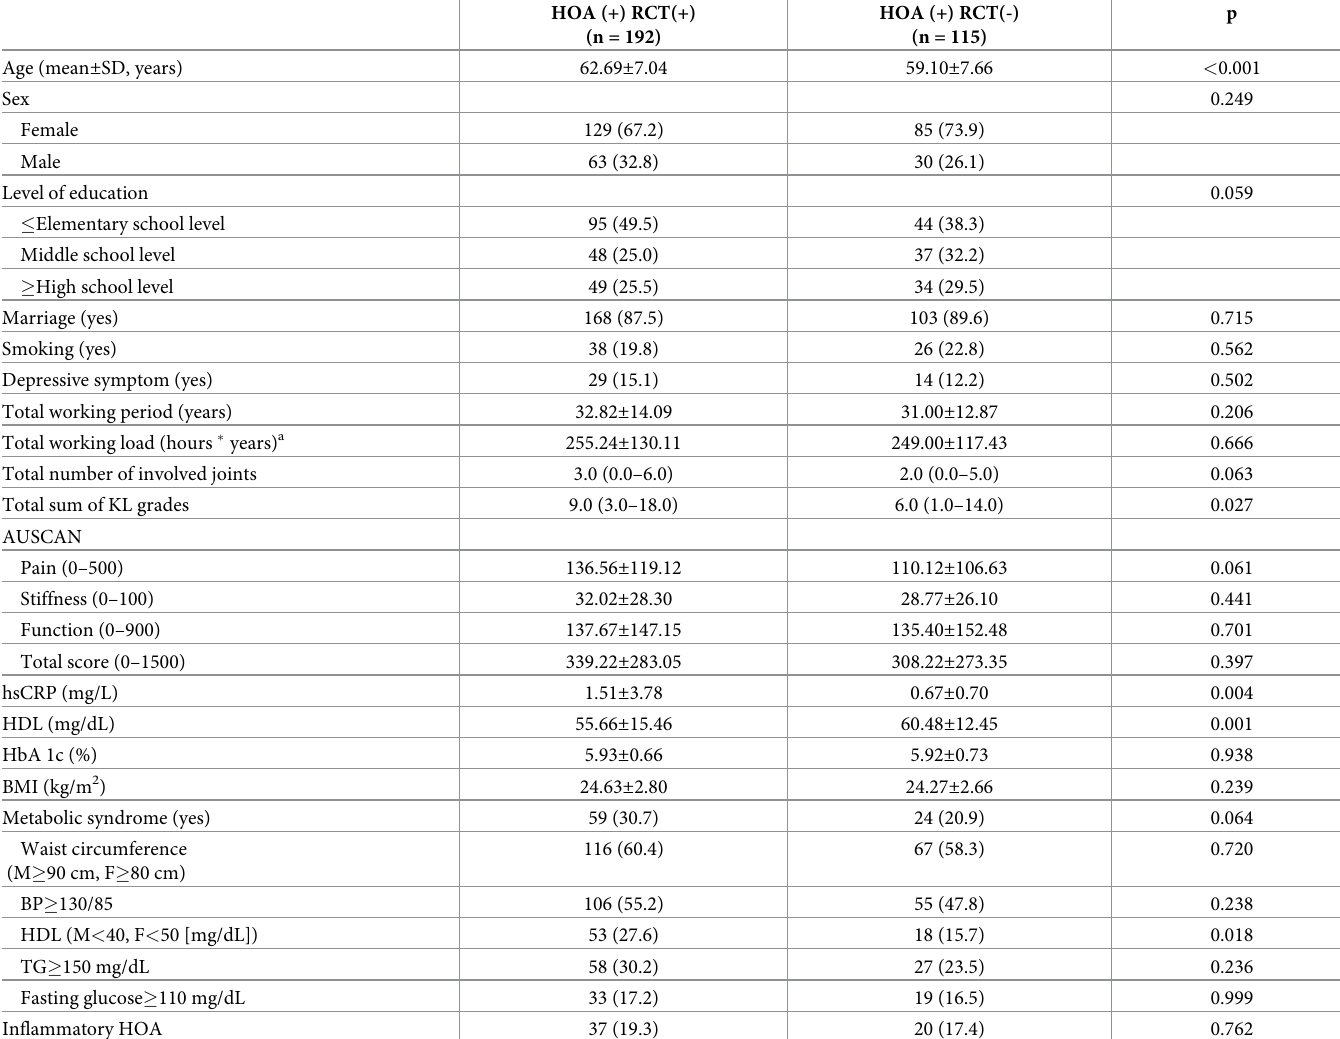
Table 1. Comparison of the participants with rotator cuff tear and those without rotator cuff tear in hand osteoarthritis (n = 307).